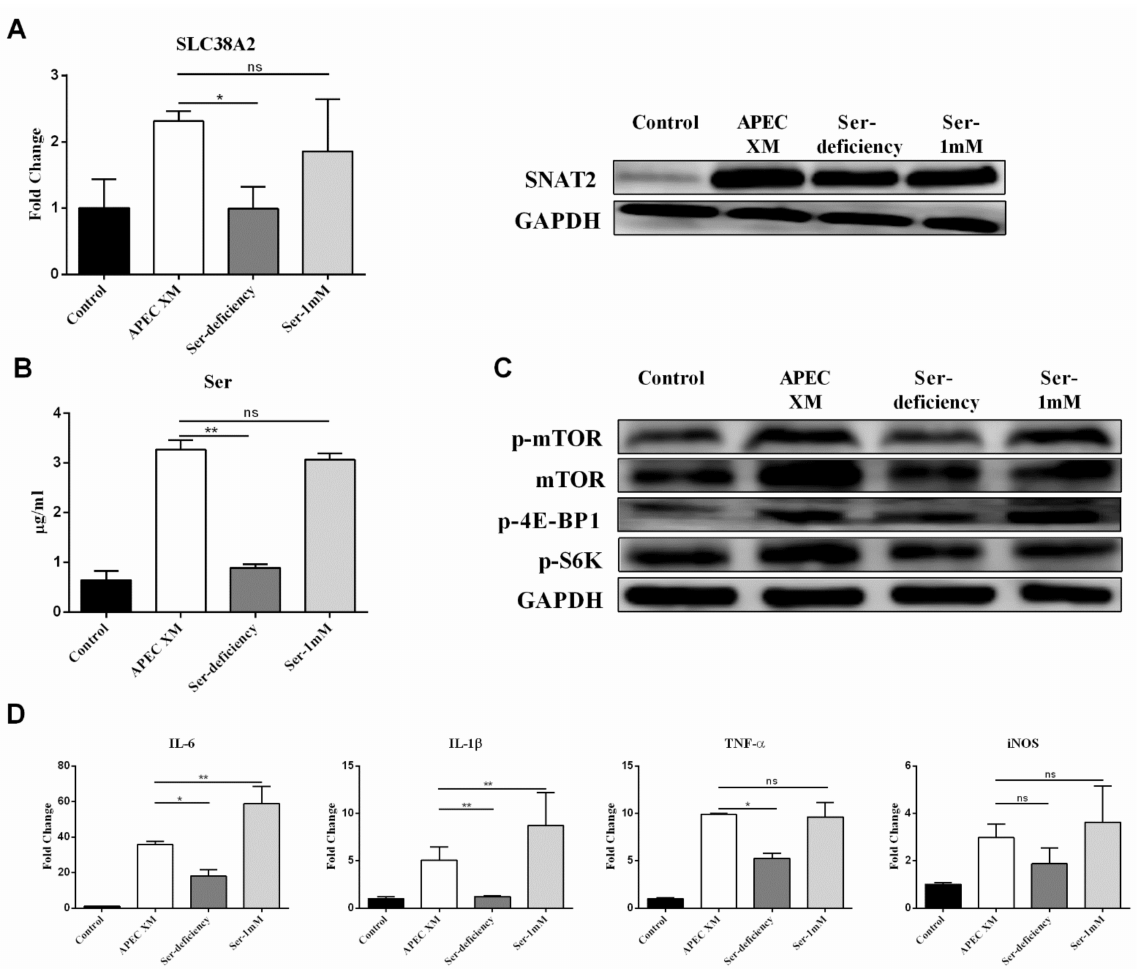
Figure 4. Serine involved in APEC XM-induced the expression of SNAT2, activation of mTOR pathway and inflammation in bEnd.3 Cells. ( A ) The transcription and expression levels of Slc38a2 in bEnd.3 cells in the Ser deficiency or the Ser supplement medium compared with APEC XM infection cells by RT-PCR and western blot analyses. GAPDH and GAPDH were used as the reference control for RT-PCR and the blotting. The RT-PCR data were from one experiment representative of three independent experiments and were presented as mean ± SD. ( B ) The intracellular content of Ser in bEnd.3 cells in the Ser deficiency or the Ser supplement medium was respectively significantly decreased and no significant difference compared with APEC XM infection cells. ( C ) Western blotting showed the significant activation of the mTORC1 pathway in bEnd.3 cells in the Ser deficiency or the Ser supplement medium. GAPDH was used as the reference control. ( D ) The mRNA expressions of pro-inflammatory factors in bEnd.3 cells in the Ser deficiency or the Ser supplement medium compared with APEC XM-infected cells were shown. GAPDH was used as the reference control. Data are from one experiment representative of three independent experiments, with three to six replicates per group. Data represent means ± SD. ns: not significant, * p < 0.05, ** p <